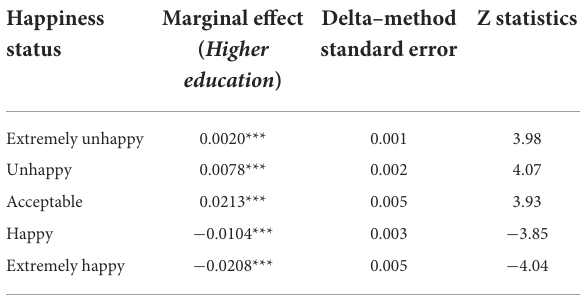
TABLE 5 Re–estimated by probit–adapted OLS approach. TABLE 6 Marginal effect of higher education on overall